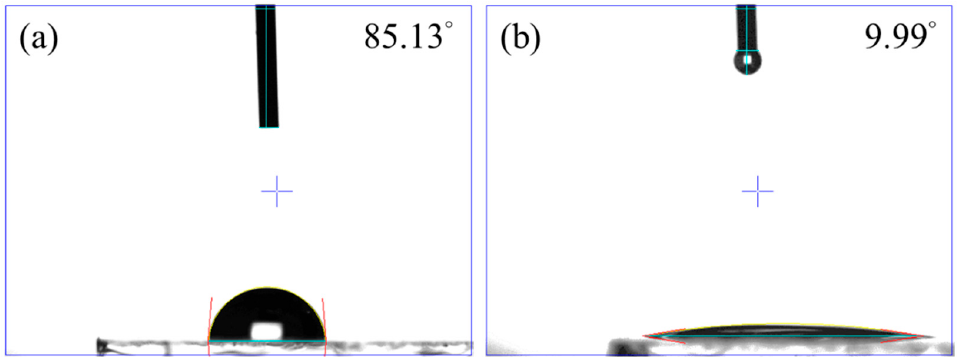
Figure 3. Cu 2 O film prepared by HiPIMS ( a ) before plasma cleaning and ( b ) after plasma cleaning of the contact angle.